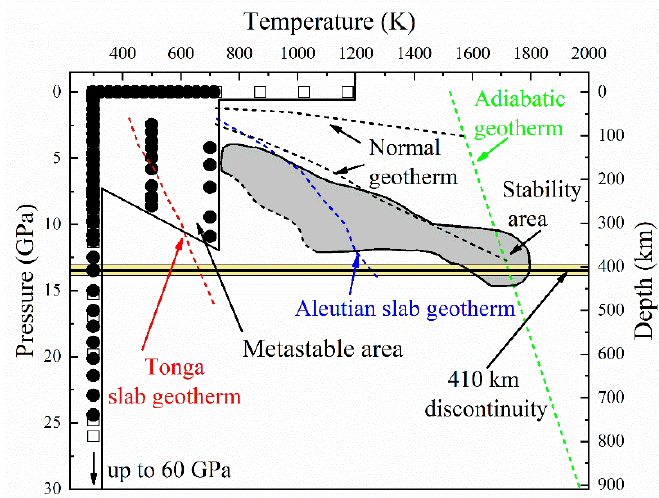
Figure 11. The P - T stability of topaz. Data of P-T stable area were obtained from Wunder et al. (1993) [18,22] and Ono et al. (1999) [23]. In the metastable area, black solid points are the data points of this experiment, and other data were obtained from Komatsu et al. (2003) [34], Gatta et al. (2006) [30], Komatsu et al. (2008) [33], Gatta et al. (2014) [32], Mookherjee et al. (2016) [35]. The dotted lines represent the Tonga slab geotherm (red), Aleutian slab geotherm (blue) (Bina and Navrotsky (2000) [62]), Normal geotherm (black) (Pollack and Chapman (1977) [59]), and adiabatic geotherm (green) (Artemieva et al. (2001) [61] and Zang et al. (2002)